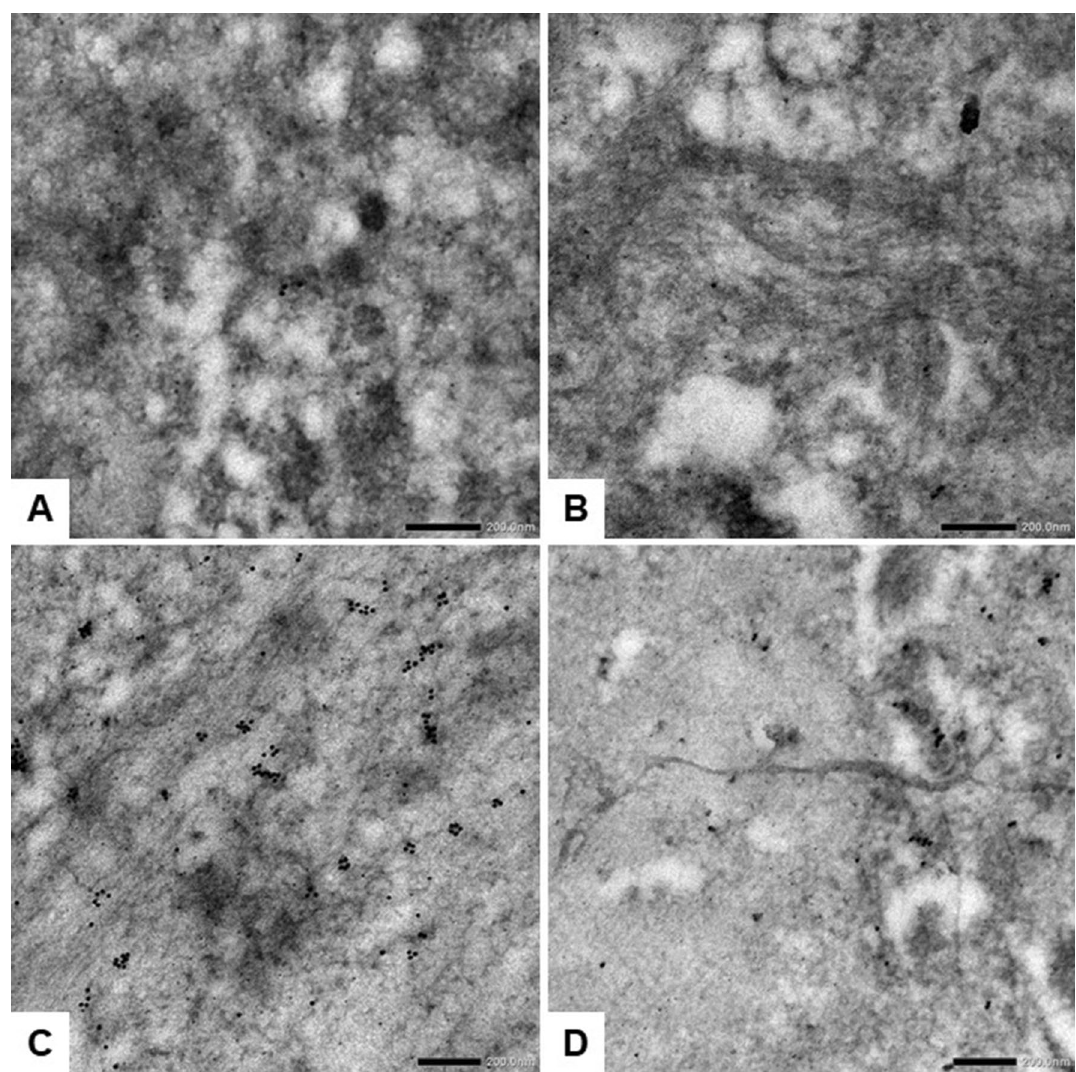
Figure 3. Immunogold transmission electron microscopy (TEM) using an α-synuclein primary antibody on pars intermedia tissue confirms presence of fibrils in a PPID-affected horse. ( A ) TEM image from the pars intermedia of an PPID-affected horse without use of the primary antibody consists of background staining of the secondary antibody. ( B ) TEM image of the pars intermedia of an aged horse shows an immunogold labeling similar to background straining. ( C ) TEM image of the pars intermedia of a PPID-affected horse exhibits immunogold labeling. ( D ) TEM image of the pars intermedia of a PPID-affected horse contains a fibril with minimal immunogold labeling in the extracellular milieu (Scale bars, 200